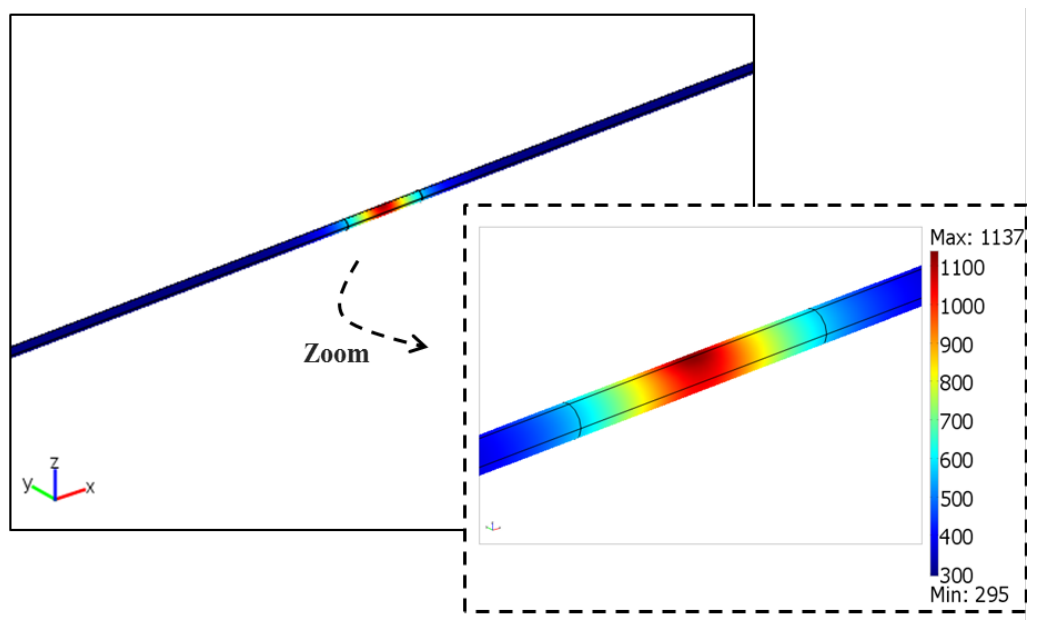
Figure 6. Temperature distribution in the implemented 3D geometry for the